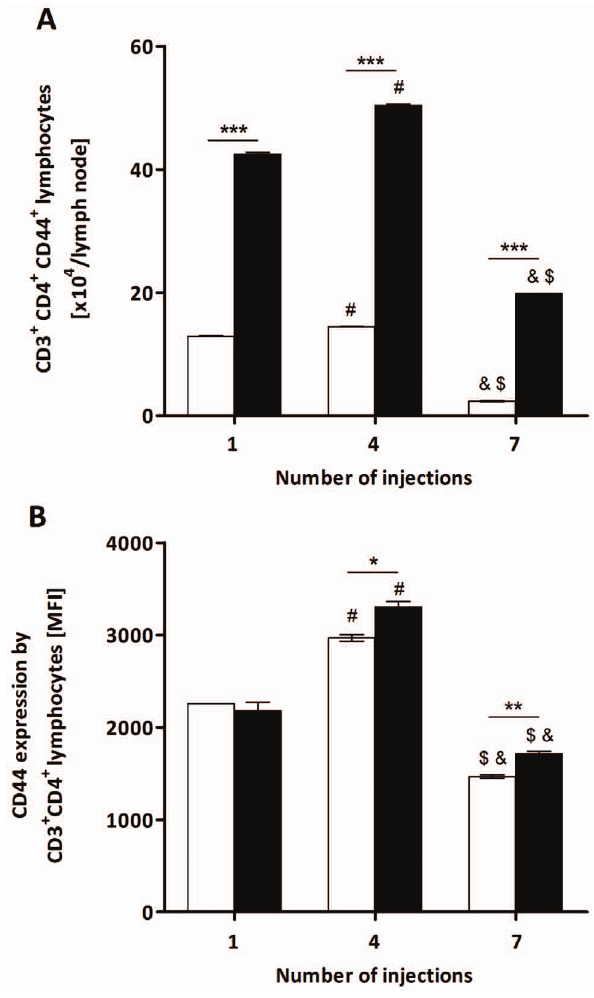
Figure 2. Total number of CD3 + CD4 + CD44 + T cells and CD44 expression from P . semirufa group. BALB/c mice were repeatedly injected with 50 m L of pyrogen-free saline ( % ) or 10 m g (protein) of the extract ( & ) into the footpad and, after the 1 st , 4 th and 7 th inoculations, the popliteal lymph nodes were collected and processed for flow cytometry analysis. (A) Total number of CD3 + CD4 + CD44 + T lymphocytes and (B) Median Fluorescence Intensity (MFI) of the expression of this molecule. All graphs show mean values 6 SD. * p , 0.05, ** p , 0.01 and *** p , 0.001: significant differences between the mean values obtained with the saline group and the mean values of the P . semirufa group. The symbols indicate significant differences between the inoculations: 1 st 6 4 th ( # ), 1 st 6 7 th (&) and 4 th 6 7 th ( $